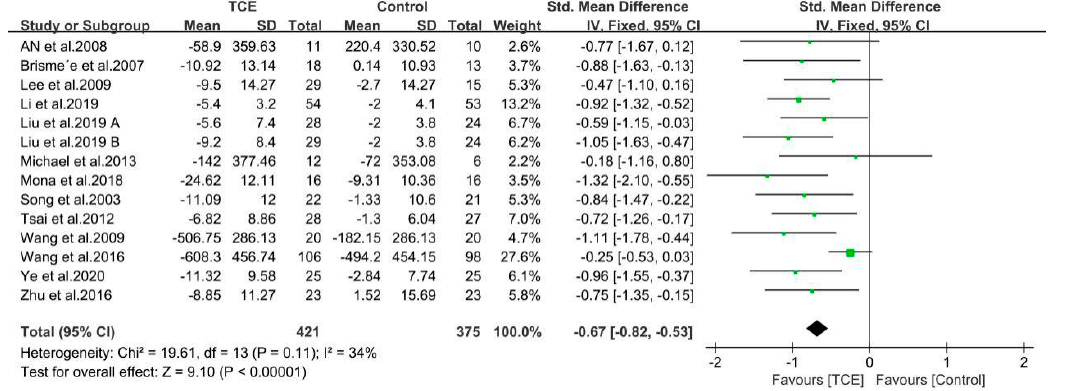
Figure 6. Forest plots showing standardized mean di ff erence of change on the physical function score